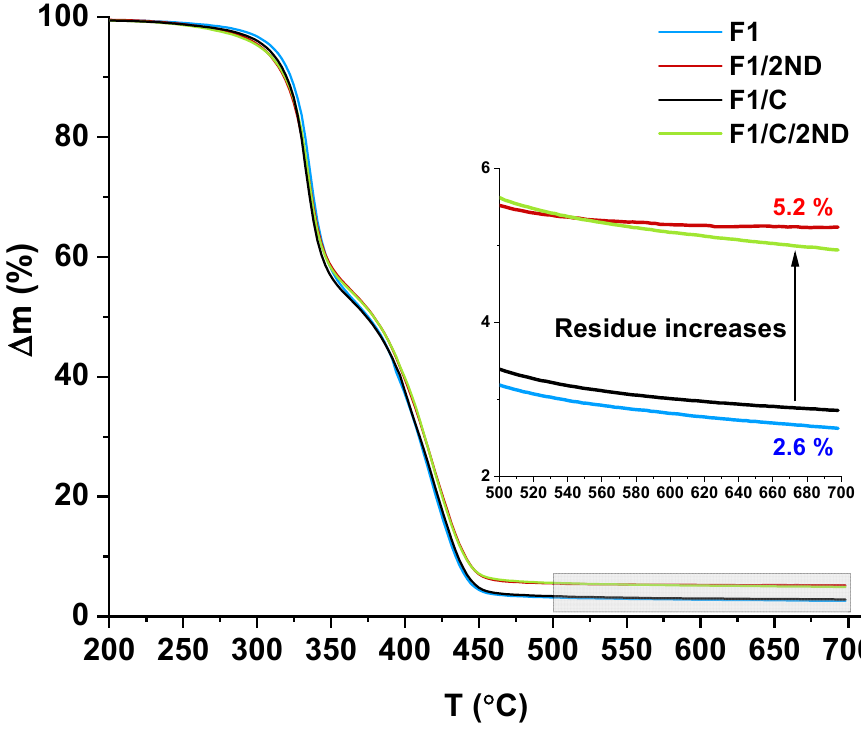
Figure 1. Thermogravimetric analysis (TGA)-curves of films with di ff erent filler contents.